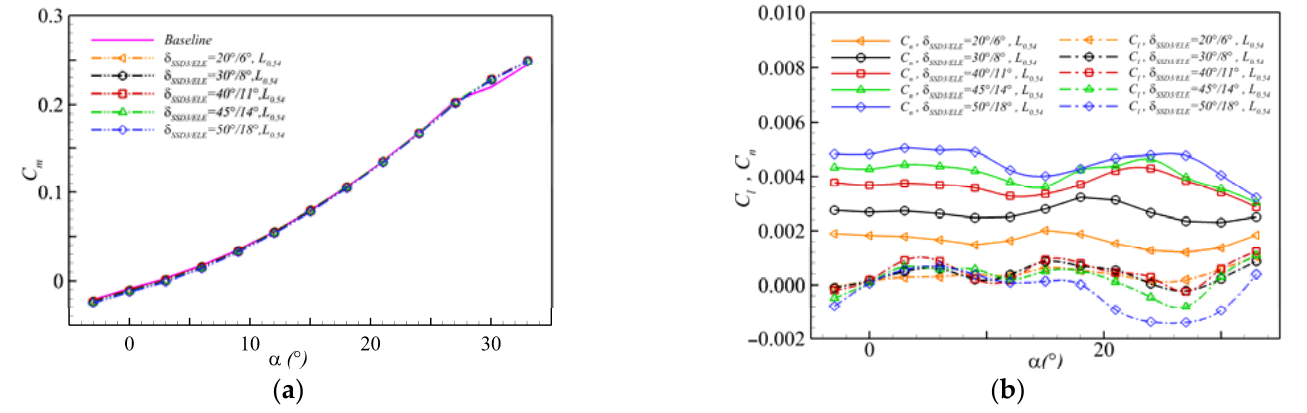
Figure 19. Control characteristics of the selected FCRs, Ma = 0.2, Re = 3.98 × 10 7 : ( a ) Pitching moment; ( b ) Yawing and rolling moments. ( b ) Yawing and rolling